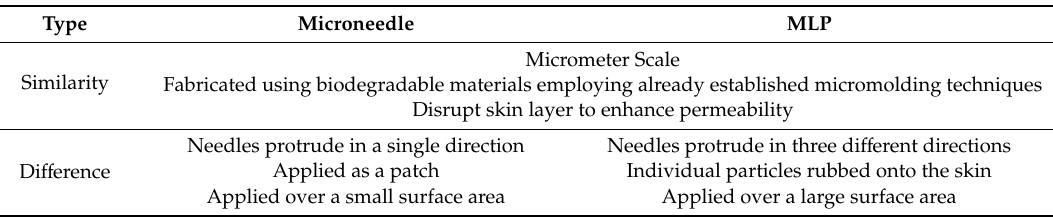
Applied over a large surface